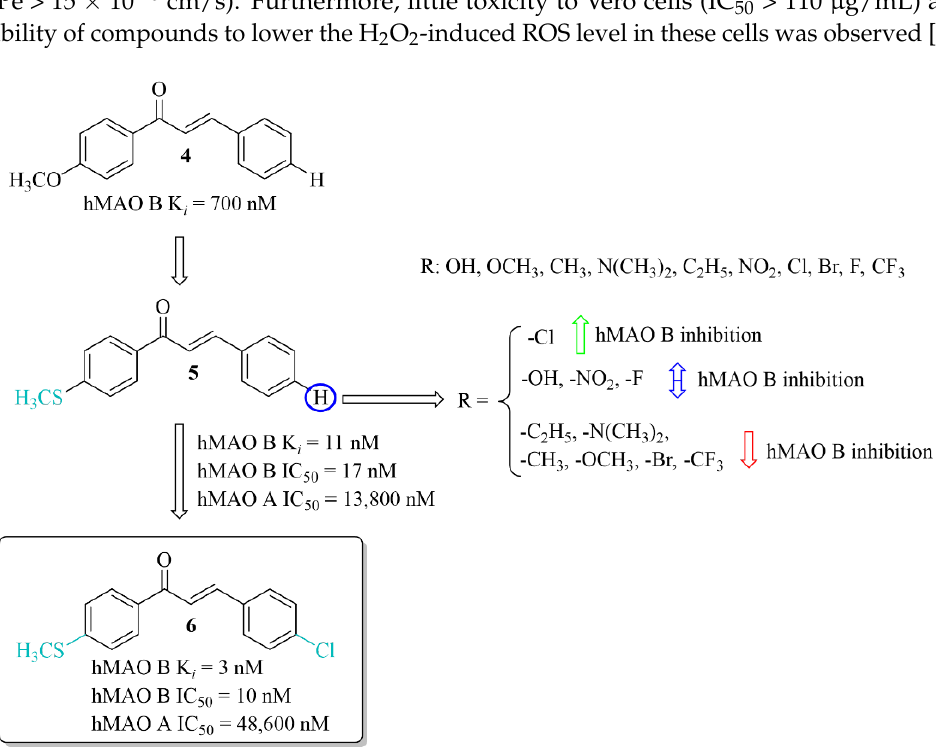
Figure 8. Thioethers and the most potent compound in the series